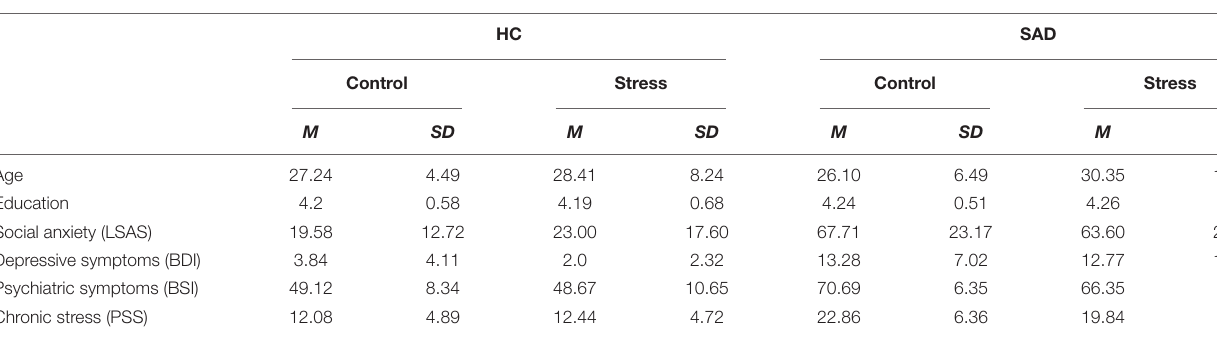
TABLE 1 | Sample characteristics.